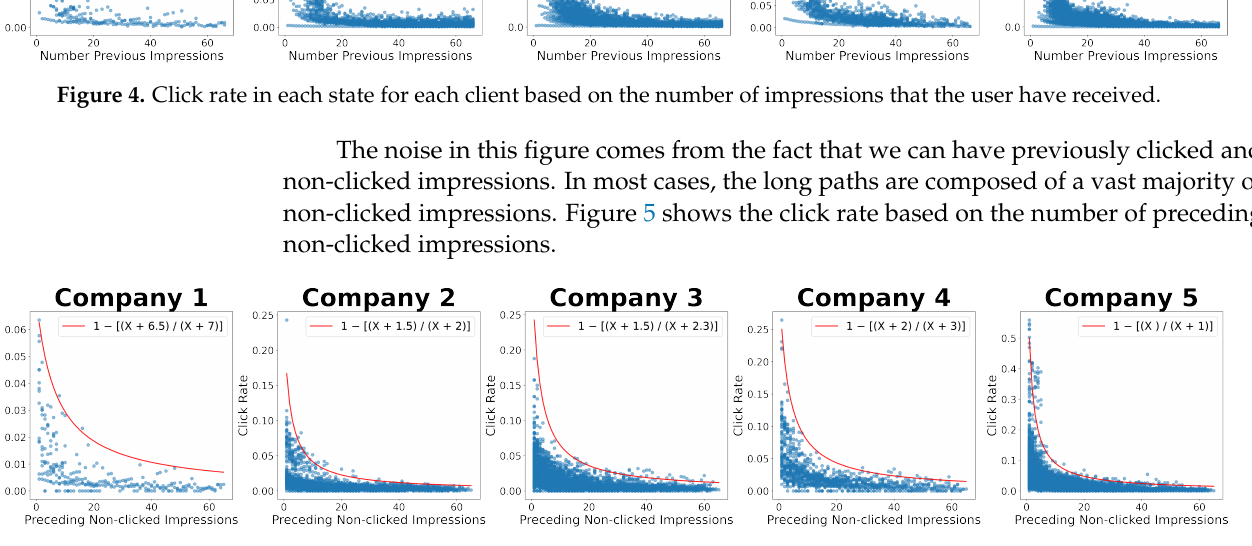
Figure 5. Click rate in each state for each client based on the number of previous non-clicked impressions for the given